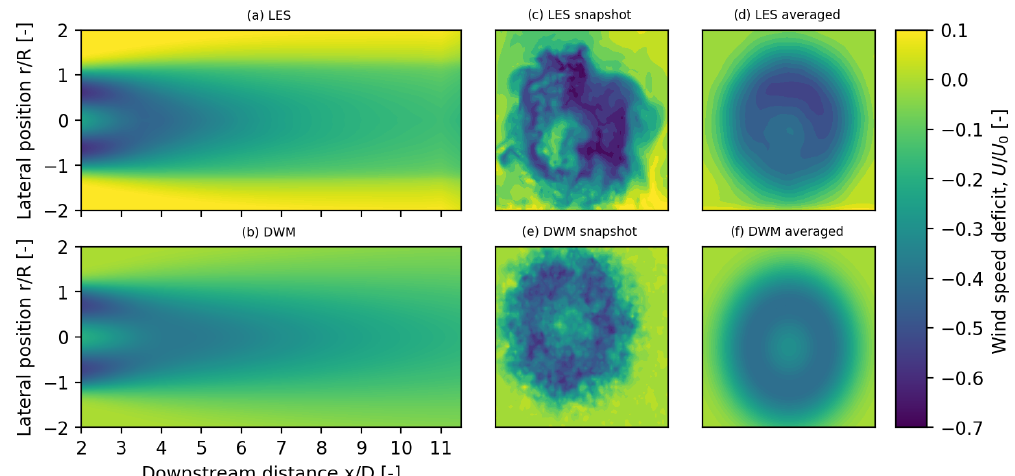
Figure 4. Visualizations of the LES and DWM wakes represented as the averaged wake downstream evolution (a, b) , wake profile snapshots at x = 3 D (c, e) , and wake-averaged wake profiles at x = 3 D (d, f)